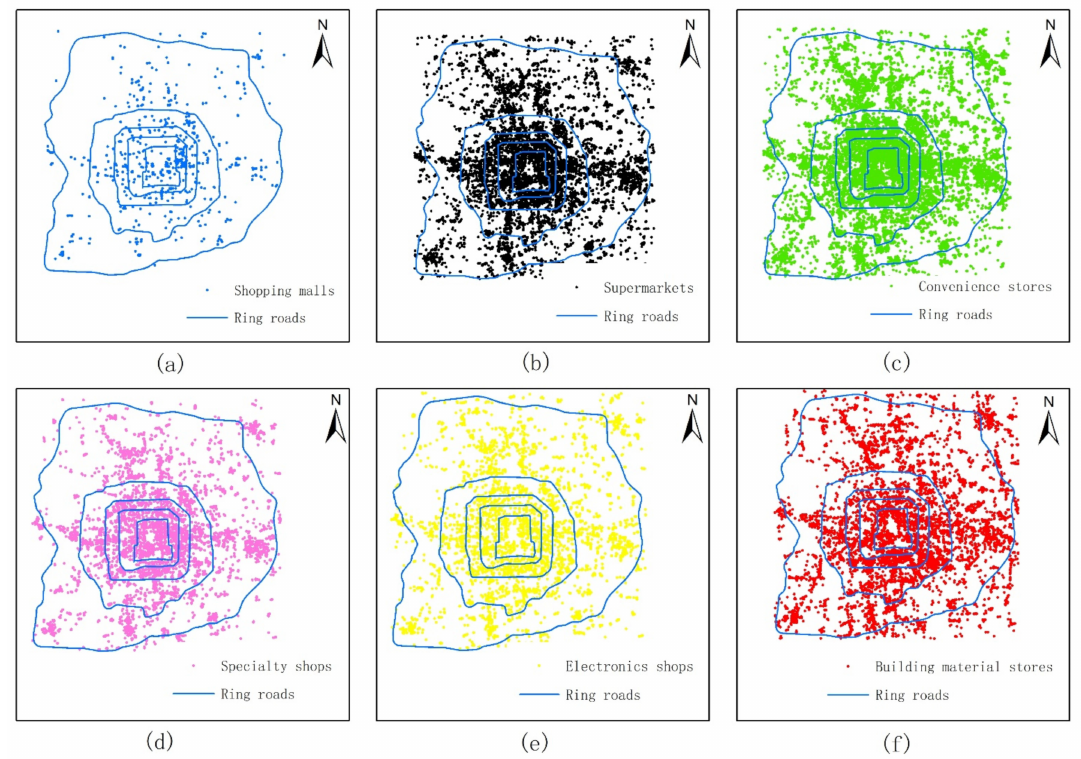
Figure 2. The POI distributions of six types of retail stores: ( a ) shopping malls; ( b ) supermarkets; ( c ) convenience stores; ( d ) specialty stores; ( e ) electronics stores; ( f ) building material